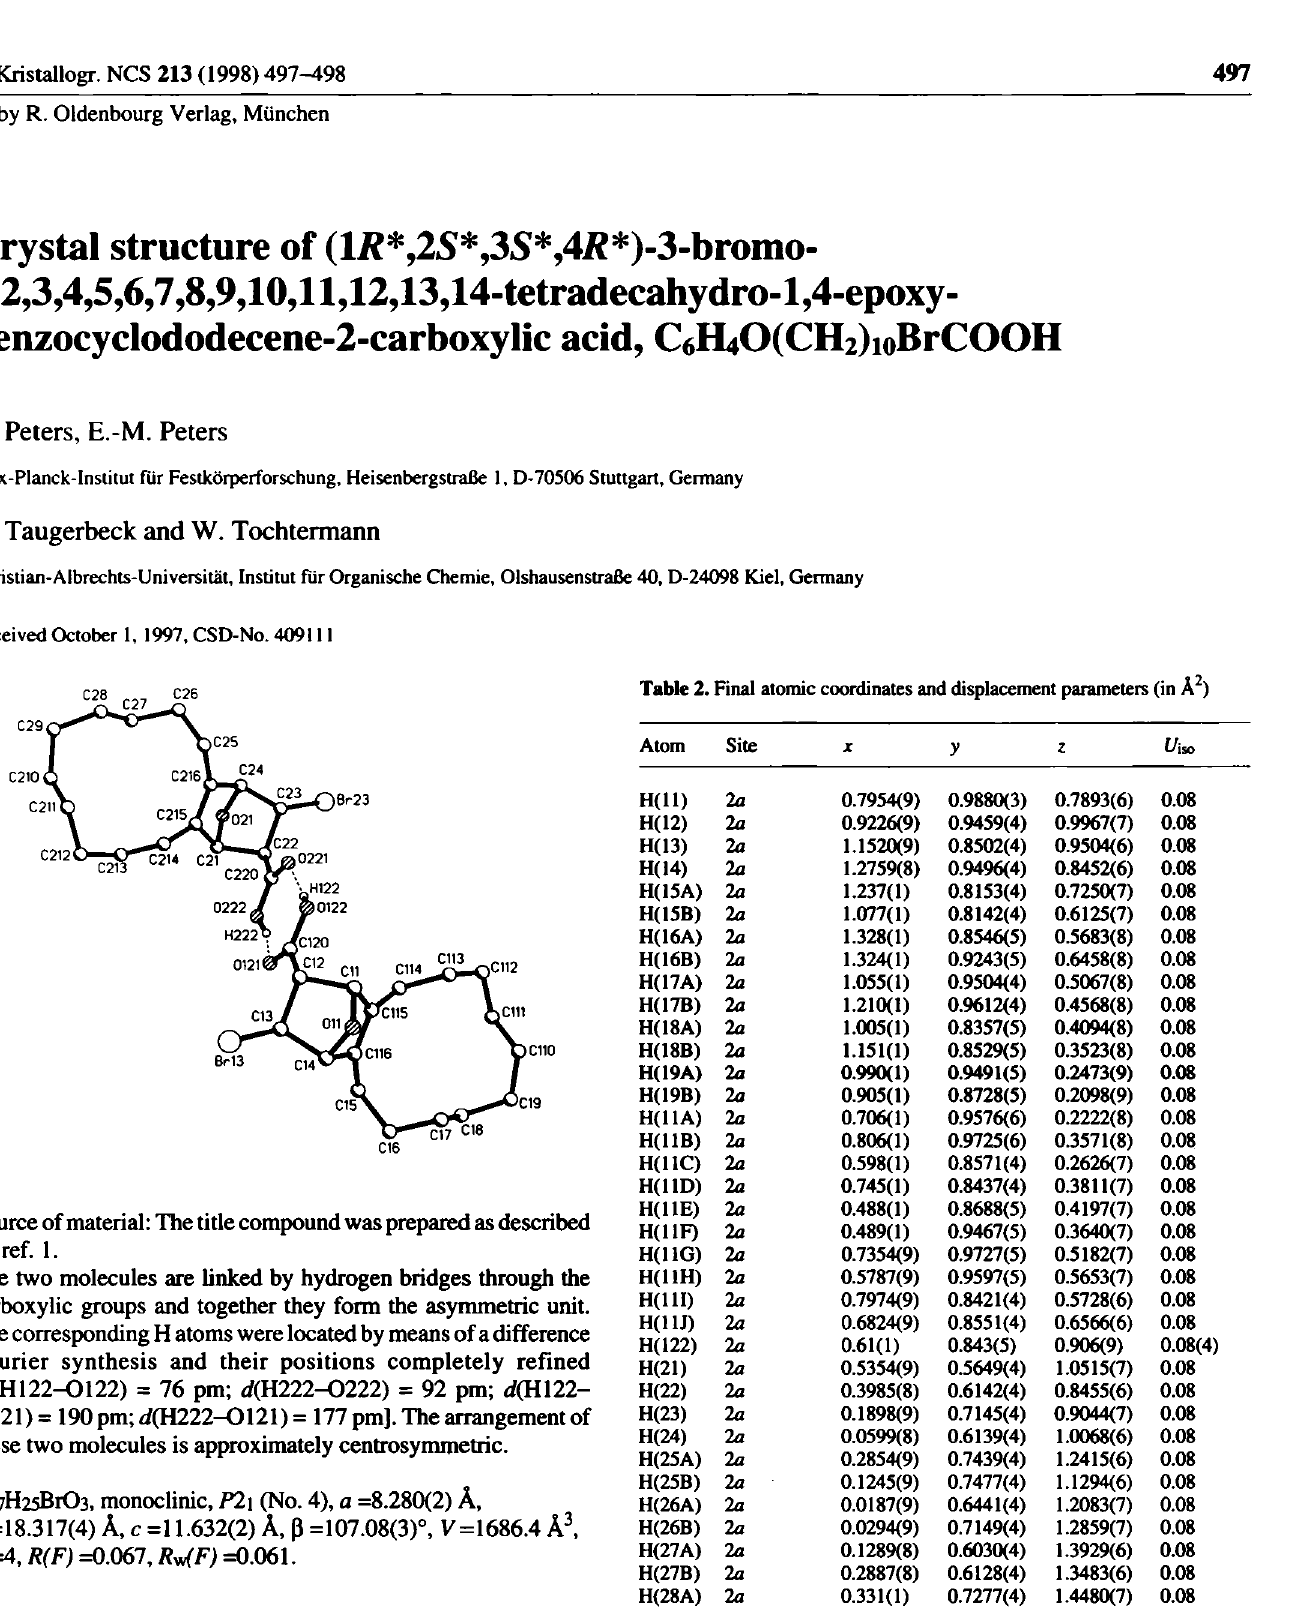
Table 1. Parameters used for the X-ray data collection Crystal: